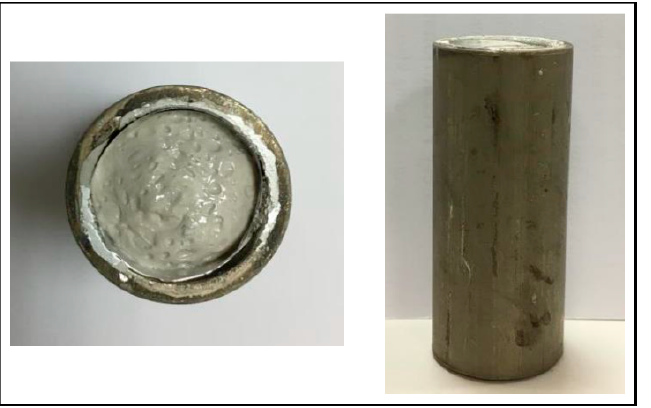
Figure 5. Samples after the foaming process and removal from the oven, ready to be extracted from the molds.